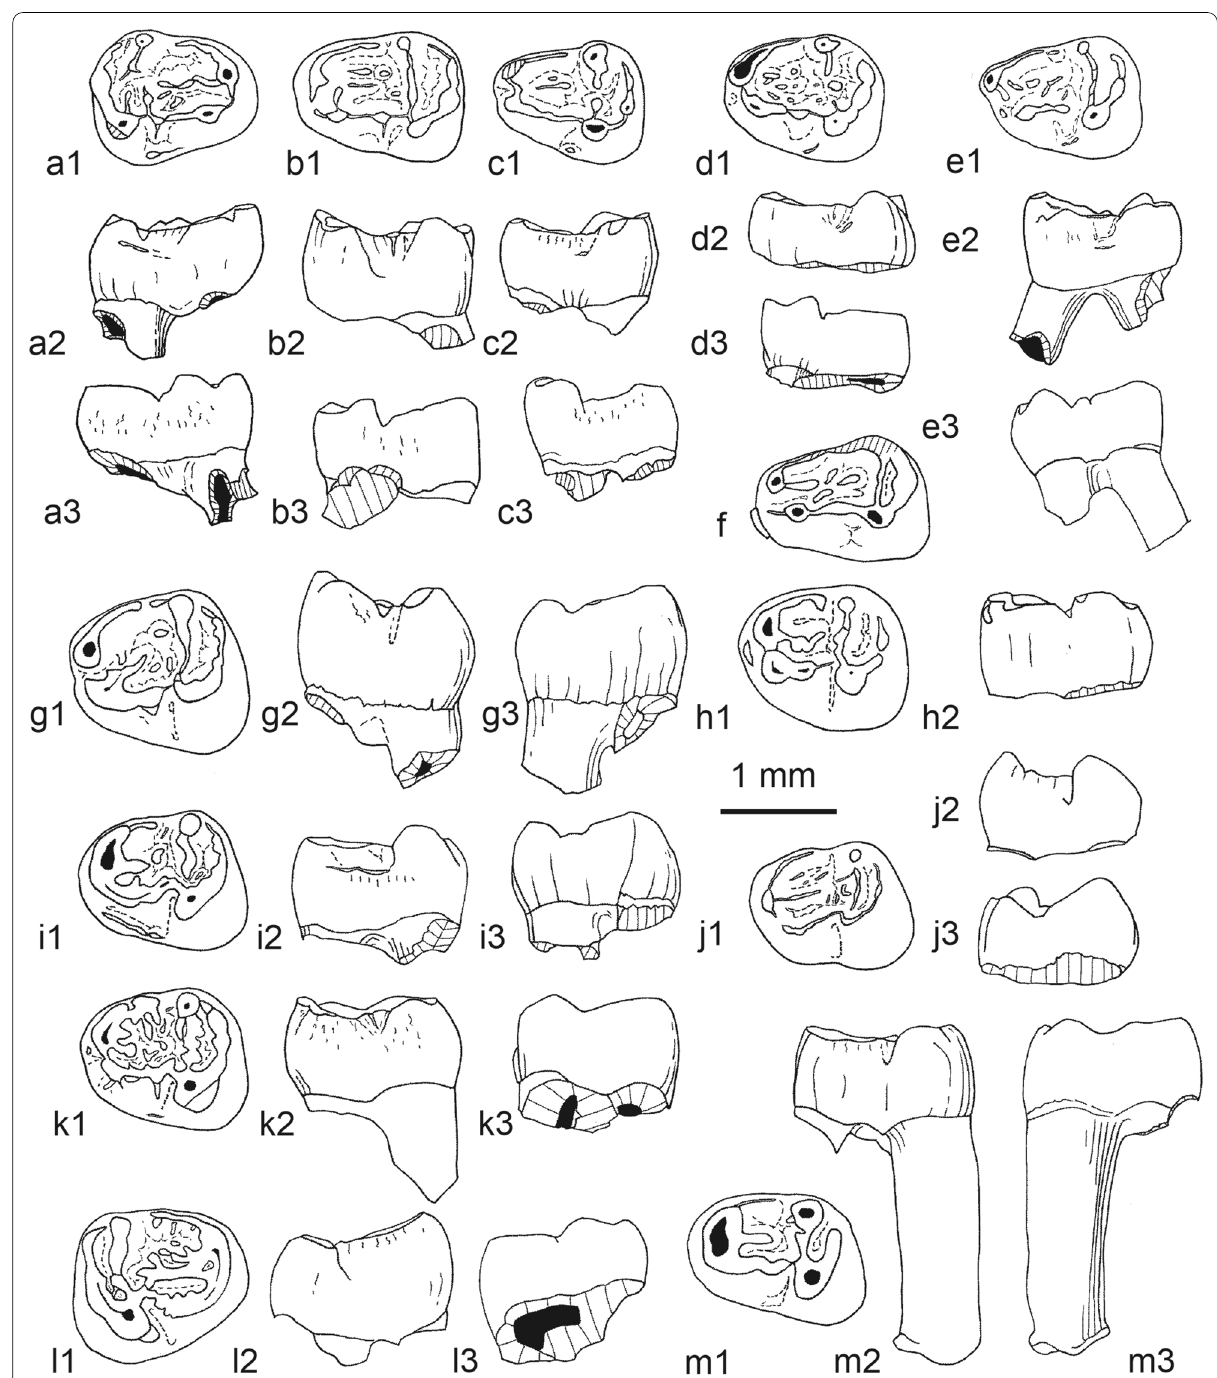
Fig. 33 Lower dp4 and p4 of ? Protadelomys alsaticus Hartenberger, 1969 from Bouxwiller (Bas‑Rhin). a CSBX43, right dp4; a1, occlusal view; a2, buccal aspect; a3, lingual aspect. b CH55, left dp4; b1, occlusal view; b2, buccal aspect; b3, lingual aspect. c : BUX67‑100, left dp4; c1, occlusal view; c2, buccal aspect; c3, lingual aspect. d BUX67‑104, left dp4; d1, occlusal view; d2, buccal aspect; d3, lingual aspect. e BW56‑55, left dp4; occlusal view. f CSBX50, left dp4; f1, occlusal view; f2, buccal aspect; f3, lingual aspect. g CH26, left p4; g1, occlusal view; g2, buccal aspect; g3, lingual aspect. h BW56‑57, left p4; h1, occlusal view; h2, lingual aspect. i BUX67‑101, left p4; i1, occlusal view; i2, buccal aspect; i3, lingual aspect. j : BUX67‑102, left p4; j1, occlusal view; j2, buccal aspect; j3, lingual aspect. k : BUX67‑103, left p4; k1, occlusal view; k2, buccal aspect; k3, lingual aspect. l : BUX67‑107, right p4; l1, occlusal view; l2, buccal aspect; l3, lingual aspect. m : BUX67‑105, left p4; m1, occlusal view; m2, buccal aspect; m3, lingual aspect. Scale bar 1 =